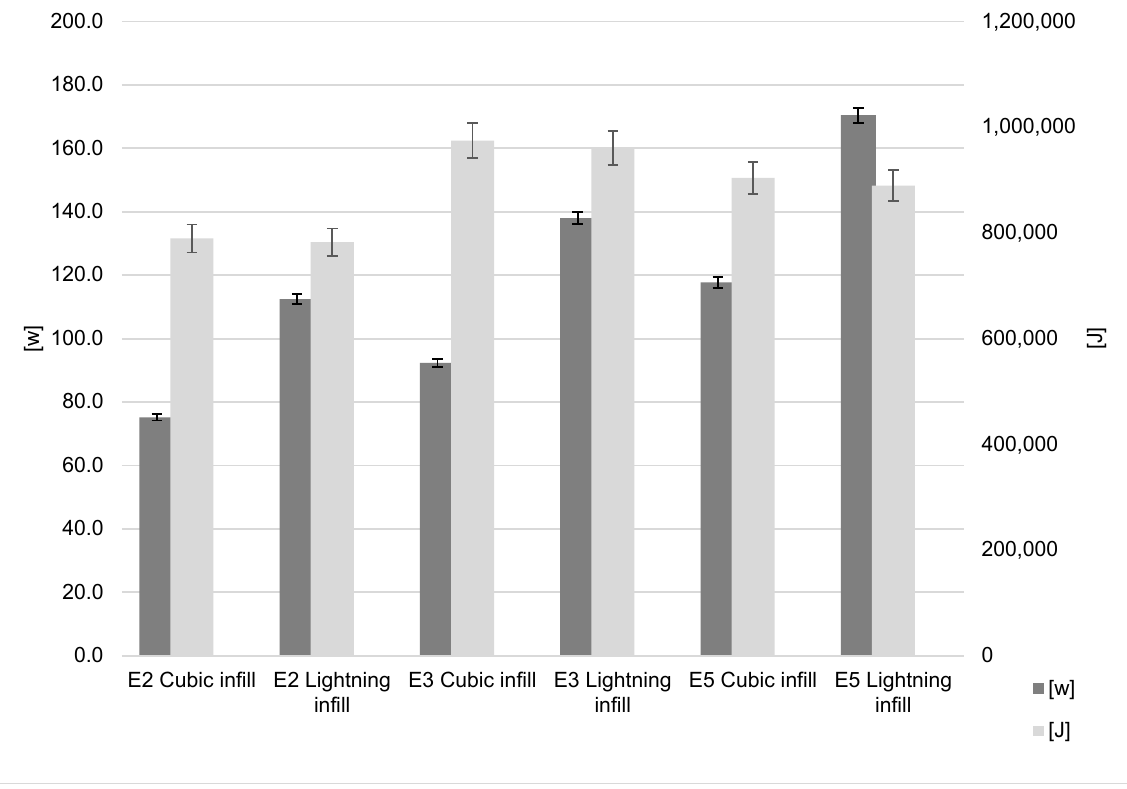
Figure 10. Infill influence on time and material results.